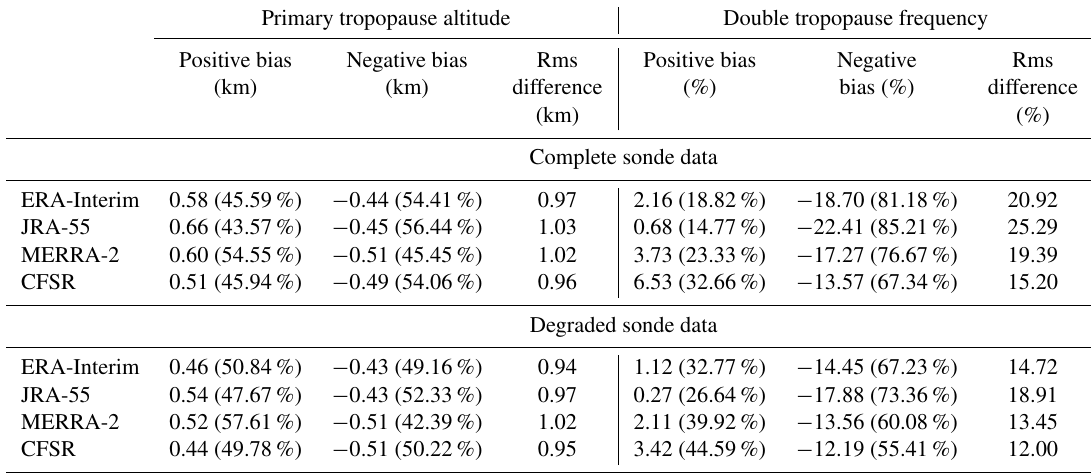
Table 1. Bias and root-mean-square differences between reanalysis tropopause identifications and radiosonde tropopause identifications. Bias is defined as reanalysis minus radiosonde, with the frequencies of positive and negative bias in parentheses. The number of radiosonde profiles used for primary tropopause altitudes and double tropopause frequencies is 99023 and 45181,